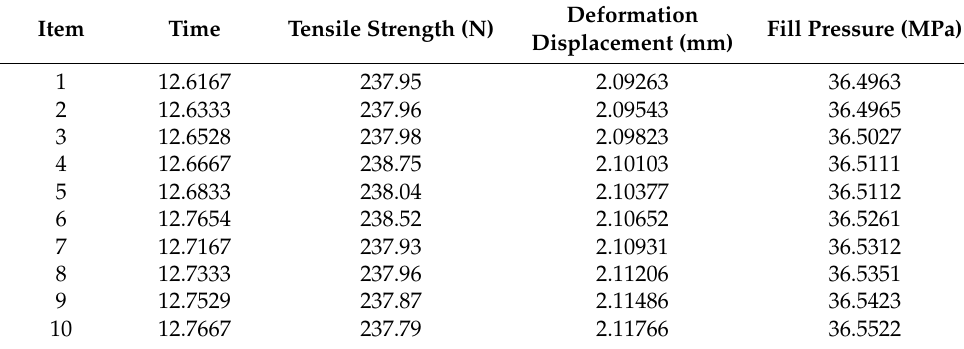
Figure 9. Tensile strength of experimental specimen. Table 3. Corresponding values record of tensile strength of specimen.